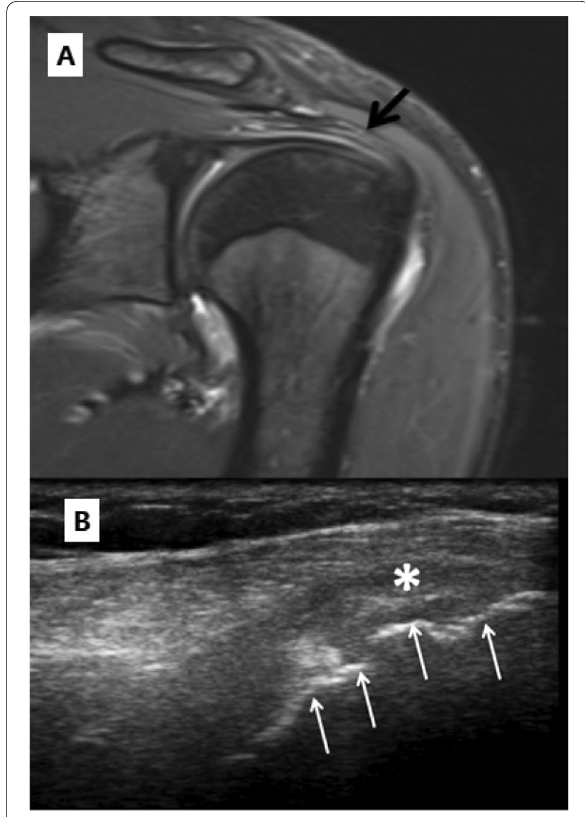
Fig. 2 Shows MRI and US images of two different patients with rotator cuff disorders. A Coronal oblique fat‑suppressed proton image of the left shoulder shows increase supraspinatus tendon thickness with high signal areas inside diagnostic of left supraspinatus tendinitis (black arrow). B US image of another patient than A shows increase supraspinatus tendon thickness with hypoechoic areas inside (asterisks) diagnostic of supraspinatus tendinitis with multiple hyperehoic supraspinatus tendon calcification (white